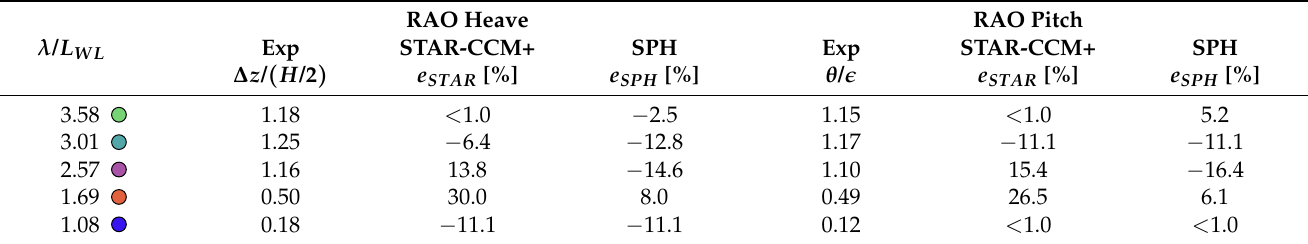
Figure 7. Response Amplitude Operator (RAO) for heave ( a ) and pitch ( b ) motion for the investigated cases. Table 4. Response Amplitude Operator (RAO) percentage errors as reported in Figure